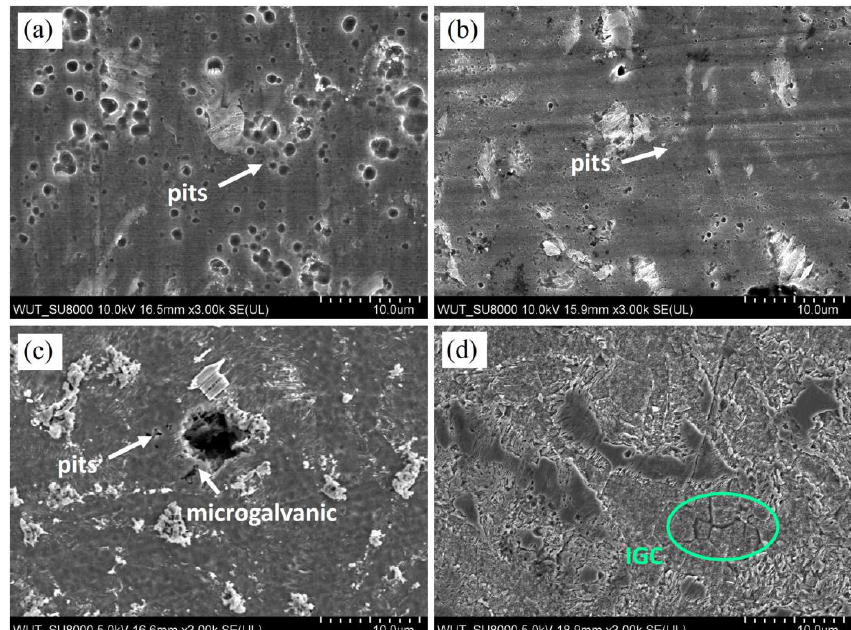
Figure 9. Characterization of the corroded surfaces of WZ42 after corrosion products removal after 1 h of immersion in ( a ) 0.01 M NaCl, ( b ) 0.1 M NaCl, ( c ) 1 M NaCl, and ( d ) PBS.